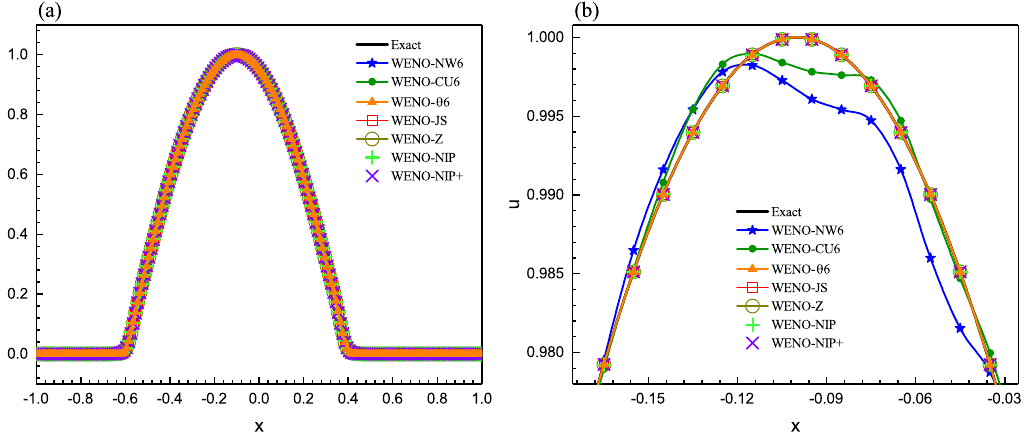
Figure 9. ( a ) Numerical solutions of Equation (13) at time t = 2.4 computed by different WENO schemes. ( b ) Zoom near the critical